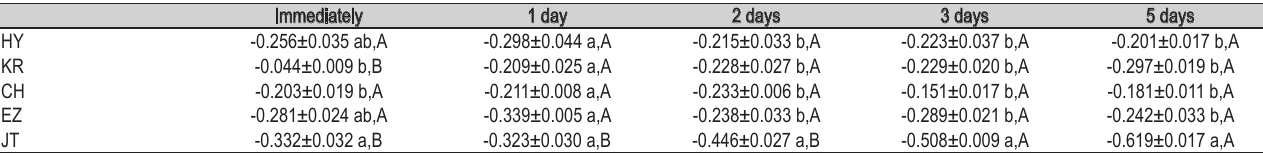
Table 3 - Mean of dimensional alteration and SD (%) of stone casts obtained with different alginates and poured in different periods of time (distance 33-37).